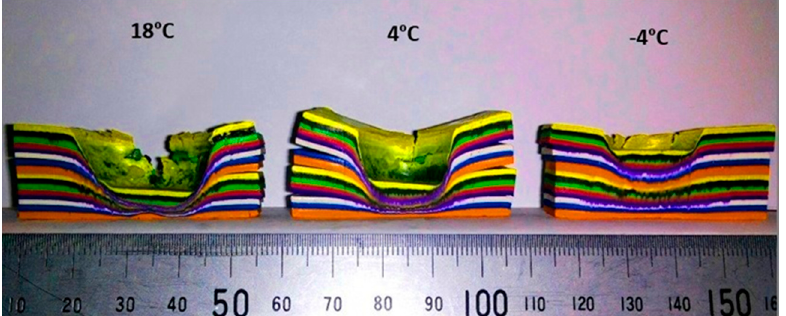
Figure 3. Cross section of the internal flow pattern of forging trials for the plasticine samples at 18 °C, 4 °C and − 4 °C working temperature.